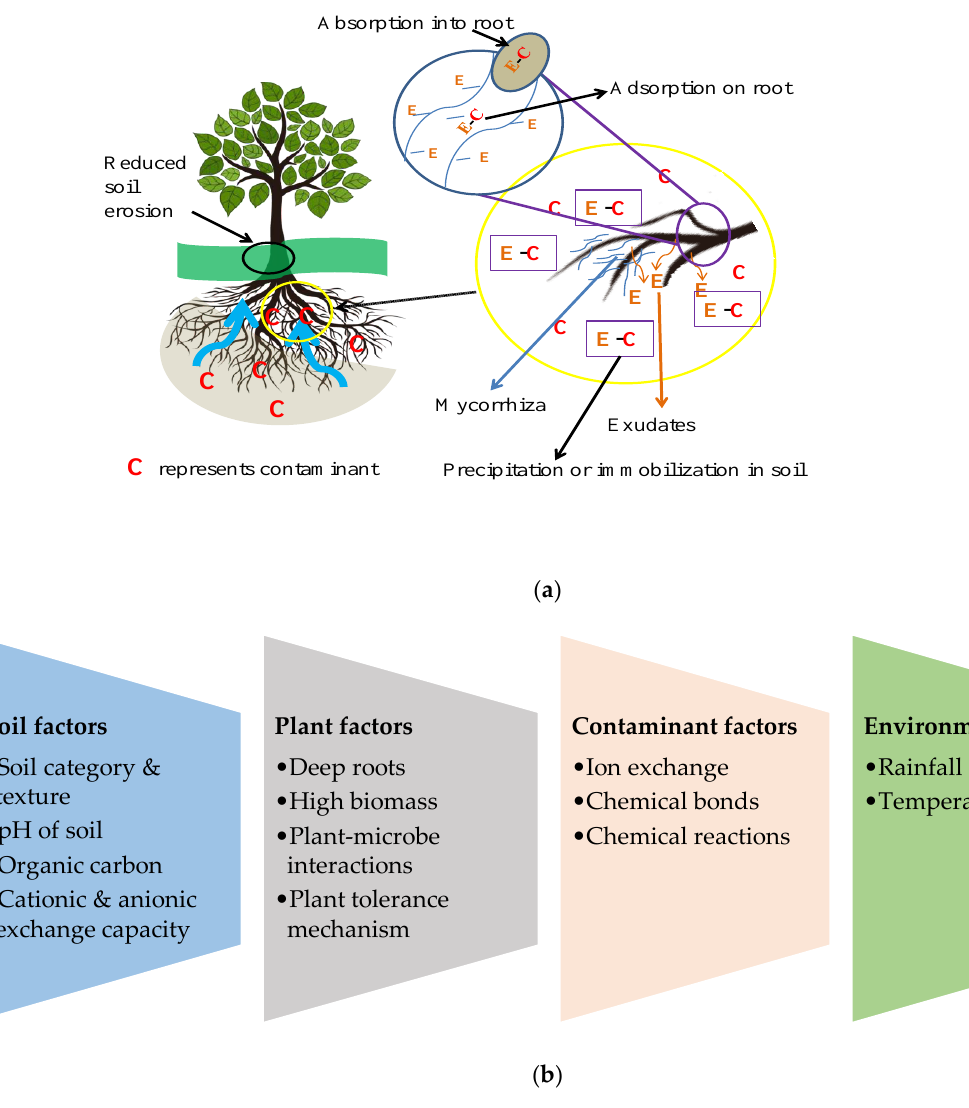
Figure 4. ( a ) Mechanisms of phytostabilization and ( b ) factors affecting the process of phytostabilization. Table 5. Suitable plant species for phytostabilization.